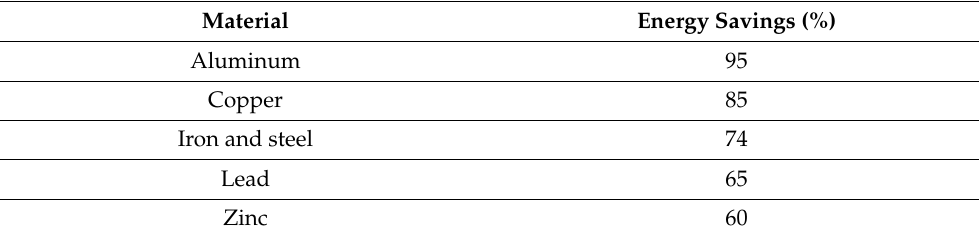
Table 3. Energy saved by using recycled materials over virgin materials